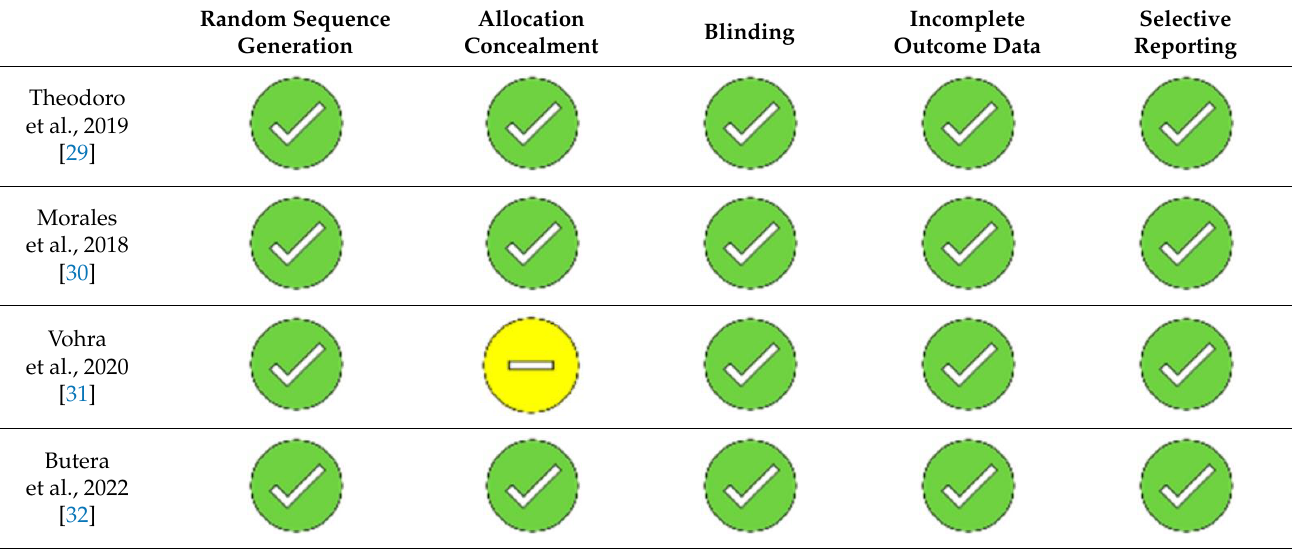
Table 2. Risk of bias (ROB) of the studies included in this review: the green symbol represents a low risk of bias, while the yellow symbol represents a high risk of bias.